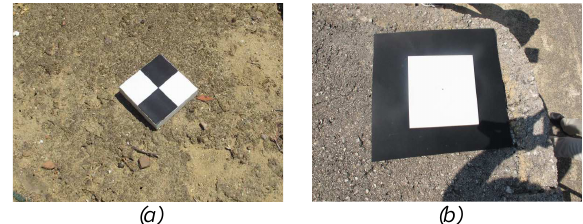
Figure 5. Targets used for the area in the Archeological